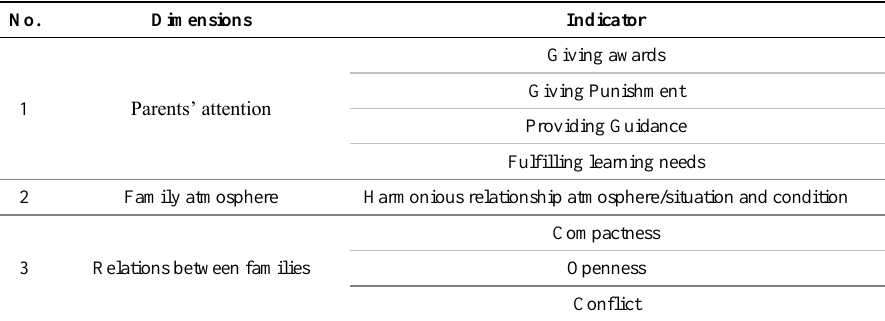
Table 2. Indicator of Family Condition